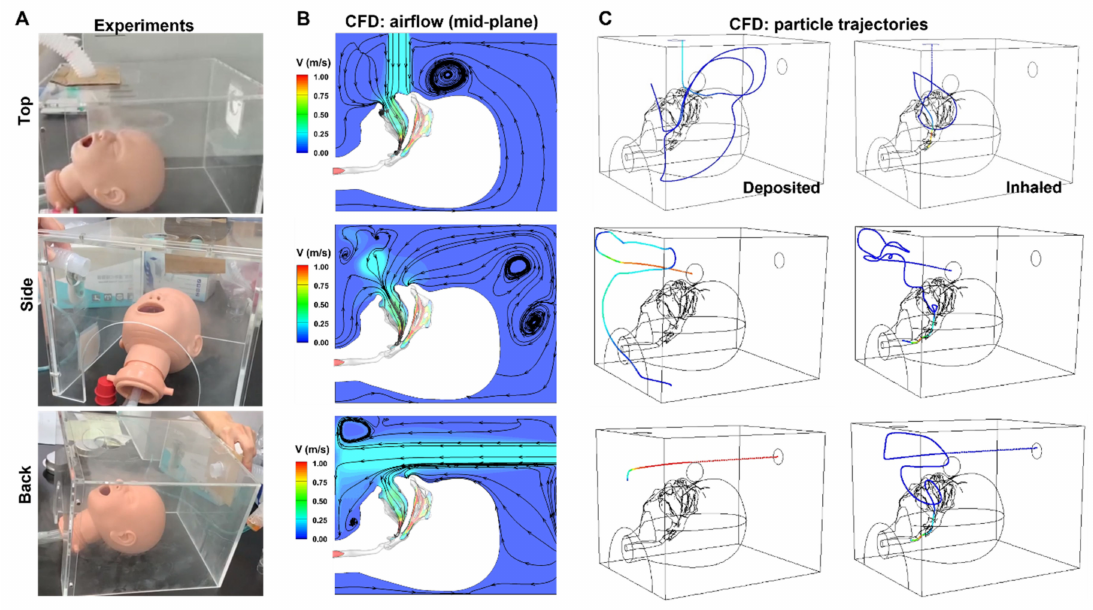
Figure 5. Experiments ( A ) vs. computational fluid dynamic (CFD) predictions: mid-plane contour of airflow speed ( B ) and trajectories of sample particles that are either deposited on the wall or being inhaled into the mouth ( C ).